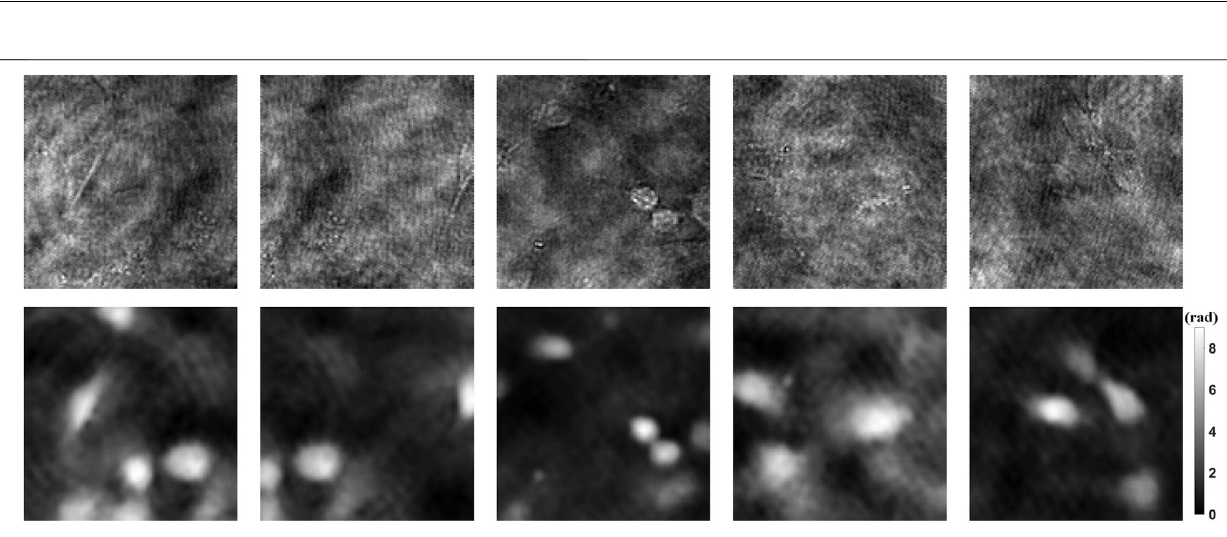
Frontiers in Physics |